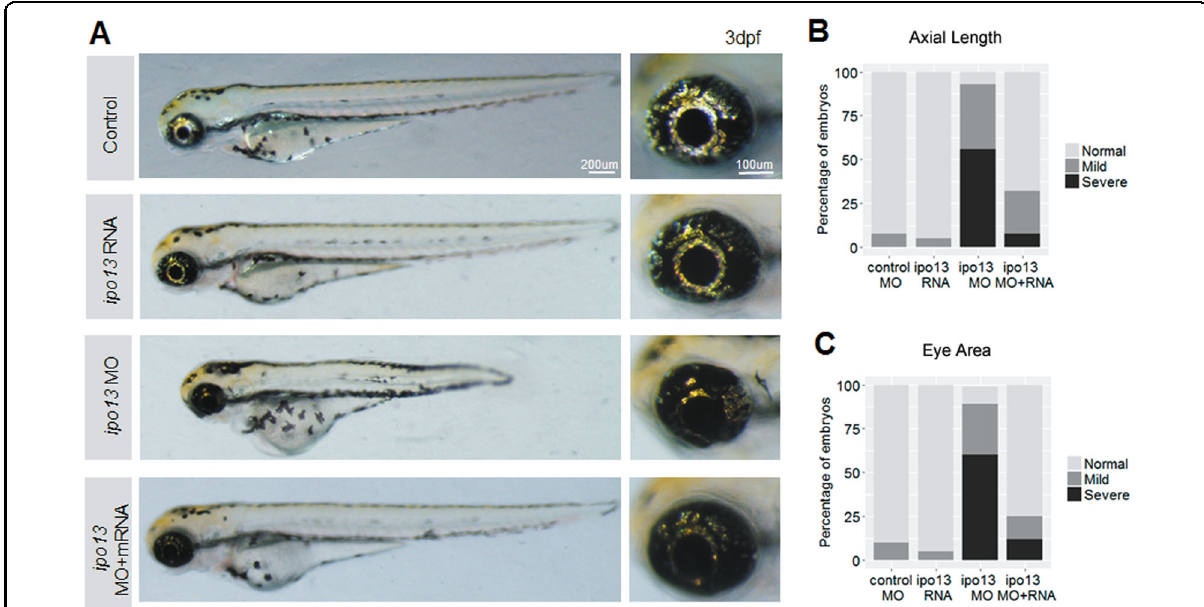
Fig. 6 ipo13 mRNA rescues the phenotypes in ipo13 -de fi cient morphants. a Lateral view of larvae injected with MO and/or rescue full-length mRNA. Larvae co-injected with MO and rescue mRNA display a relatively normal morphology that is similar to the morphology in the rescue mRNA only group on 3 dpf. Meanwhile, compared to the MO only group, the coloboma phenotype decreases signi fi cantly in the rescue group. b , c MO and mRNA co-injected larvae show dramatic recovery in both axial length ( b ) and eye area ( c ). Rescue experiments were repeated three